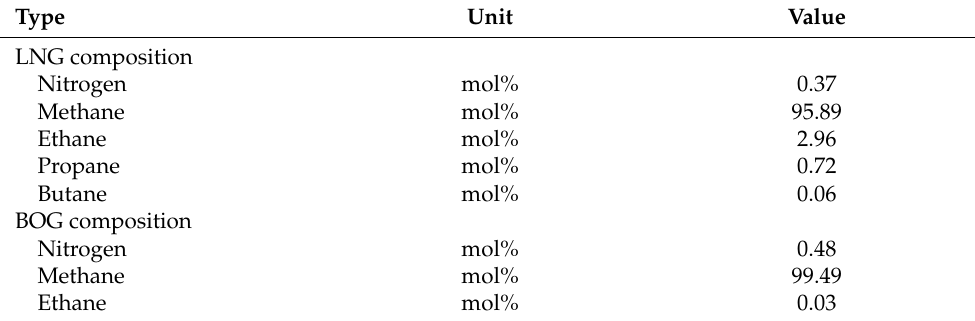
Table 1. LNG and BOG condition